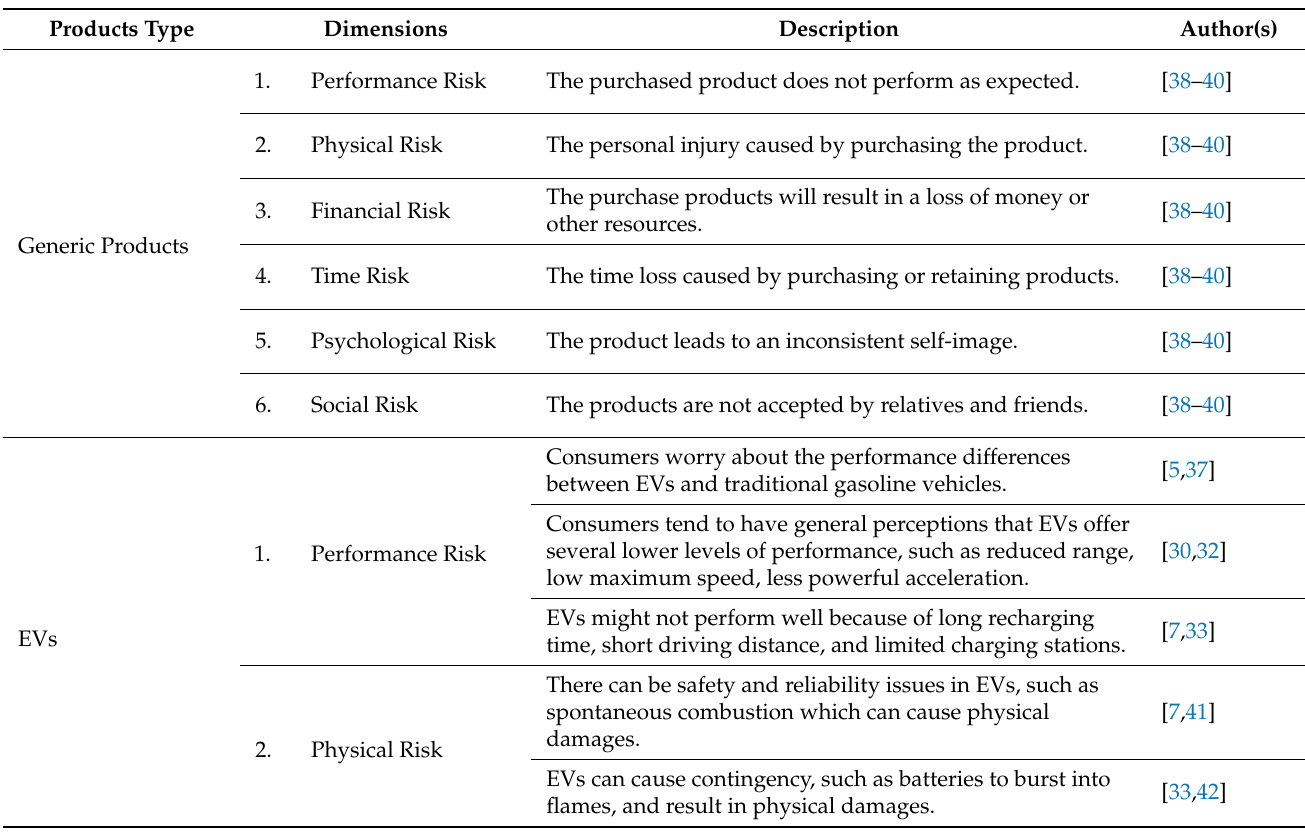
Table 1. Review of Perceived Risk Dimension